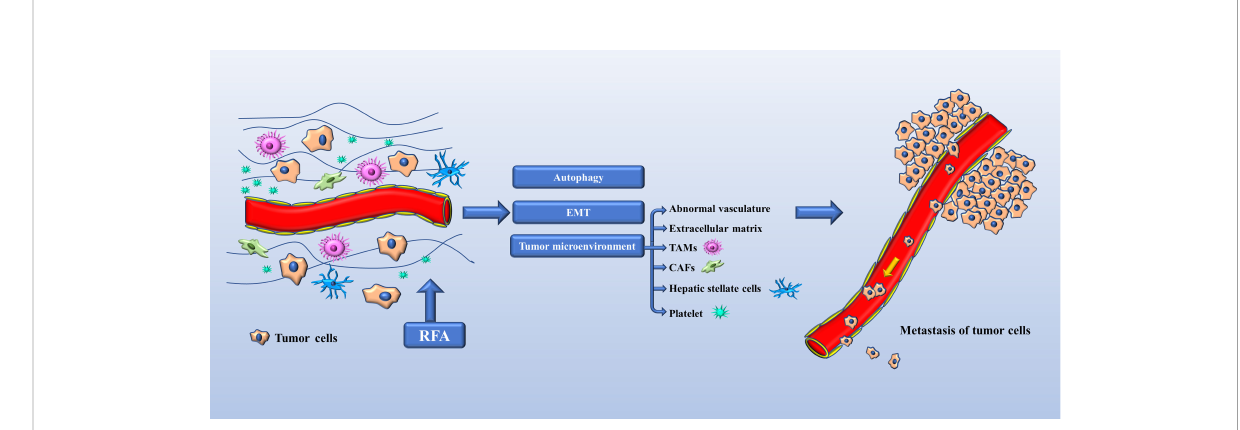
FIGURE 1 Mechanisms of tumor progression in HCC after RFA. EMT (epithelial-mesenchymal transition), TAMs (tumor-associated macrophages), CAFs (carcinoma-associated fi